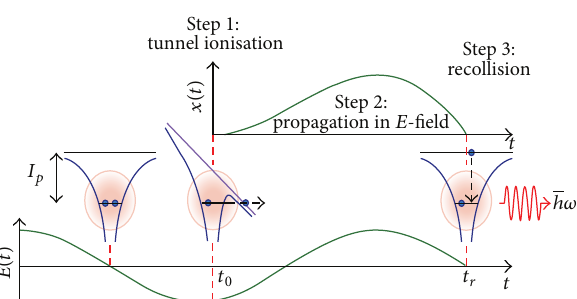
Figure 1: Three-step mechanism of high-order harmonic genera- tion. Step 1: tunnel ionization, step 2: electron acceleration in the electromagnetic field of the laser wave, and step 3: recollision and recombination with the ion and the emission of harmonics [4].